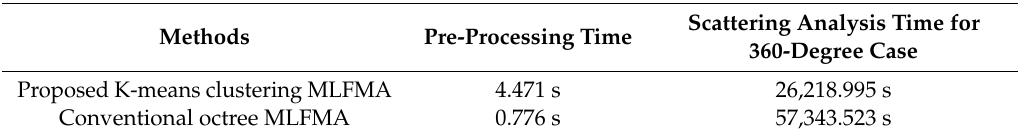
Figure 13. Realistic stealth CAD model simulation results: ( a ) the number of iterations as a function of the number of basis functions; ( b ) the computation time per iteration as a function of the number of basis functions. Table 1. Comparisons of the computation time of the conventional and proposed MLFMA for the realistic stealth CAD model.